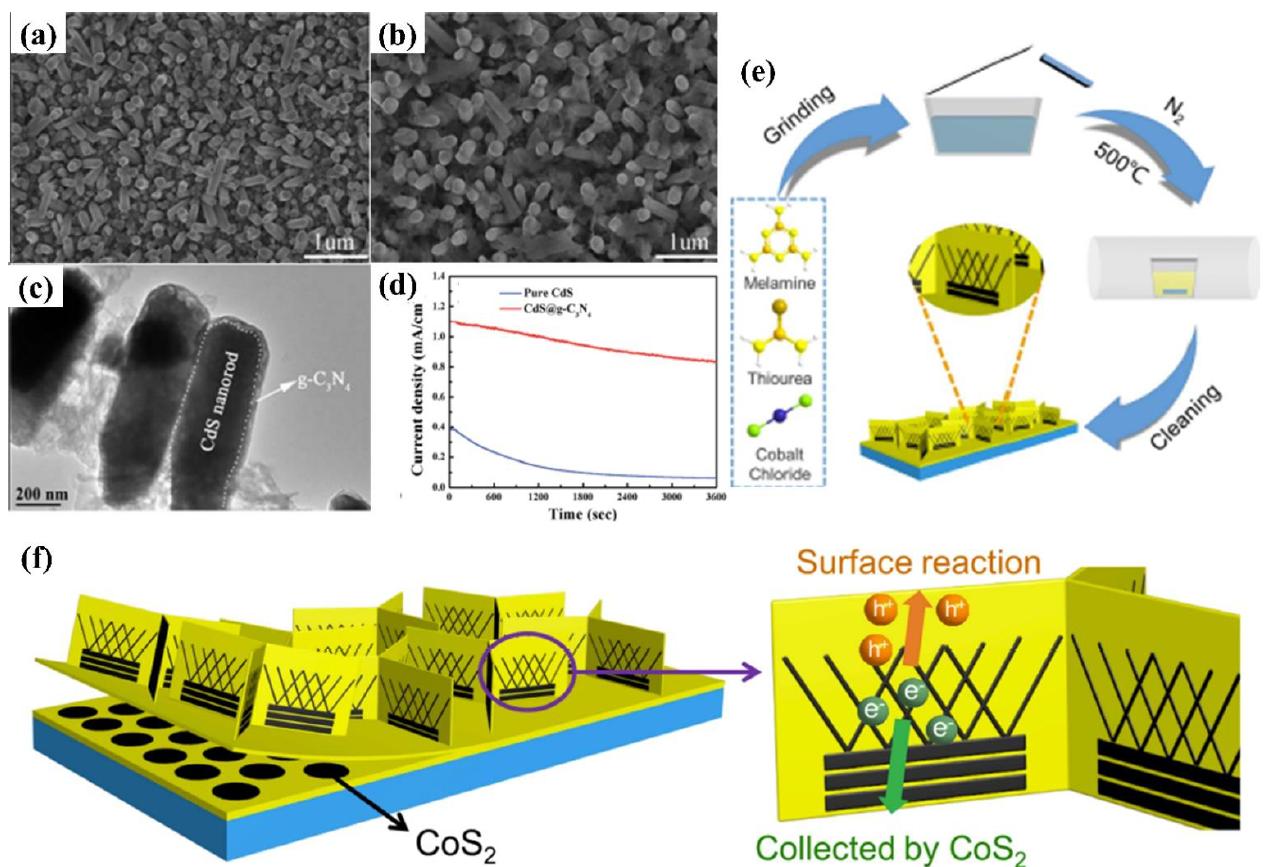
Figure 21. Top-view FESEM images of ( a ) CdS nanorods (NRs) and ( b ) CdS/g − CN core–shell nanorods (CSNRs). ( c ) TEM images of CdS/g − CN core–shell nanorods. ( d ) photostability measurements at 0.9 V versus RHE. Reprinted with permission from ref. [210] Copyright 2015 Royal Society of Chemistry. ( e ) Synthesis procedures. ( f ) The charge transfer mechanism. Reprinted with permission from ref. [206] Copyright 2022 Wiley-VCH.